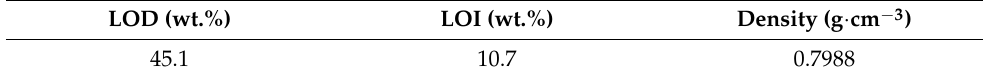
Table 2. LOD, LOI and density of waste diatomaceous